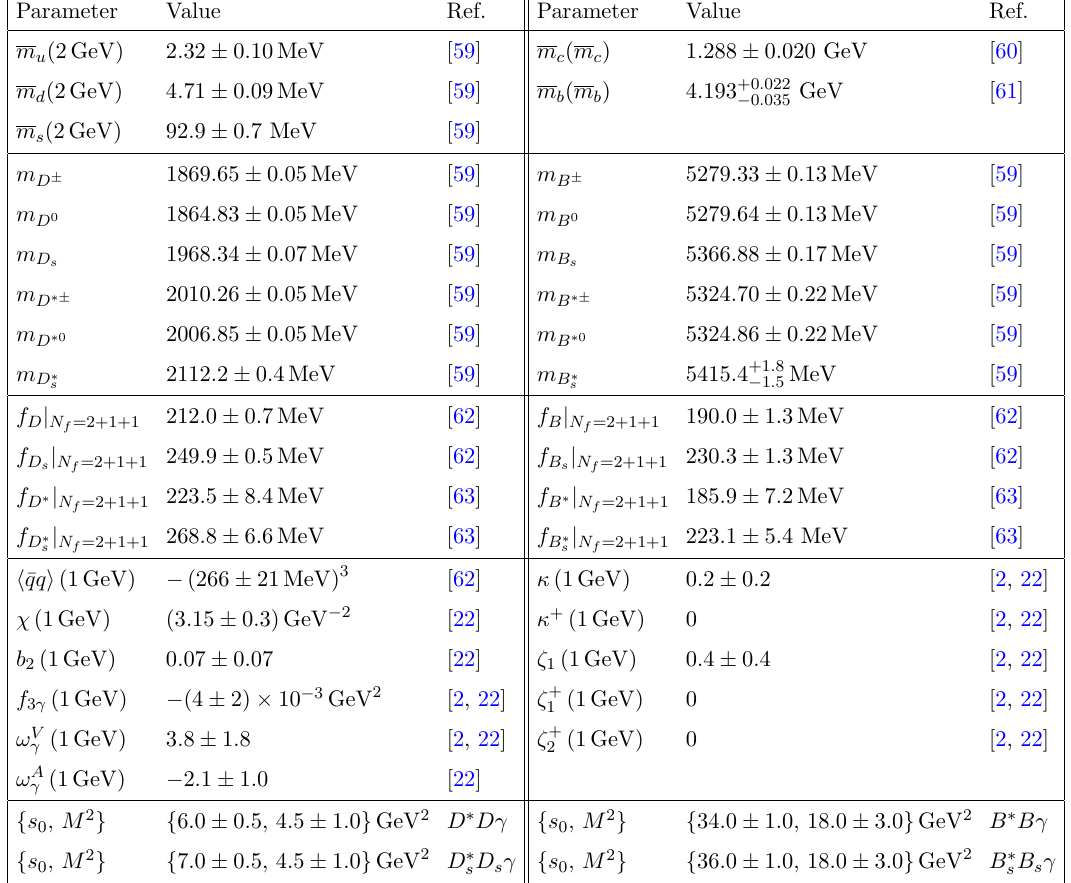
Table 1 . Numerical input values of the theory parameters employed in the improved LCSR pre- dictions for the M (cid:3) M (cid:13) couplings with the subleading twist corrections.